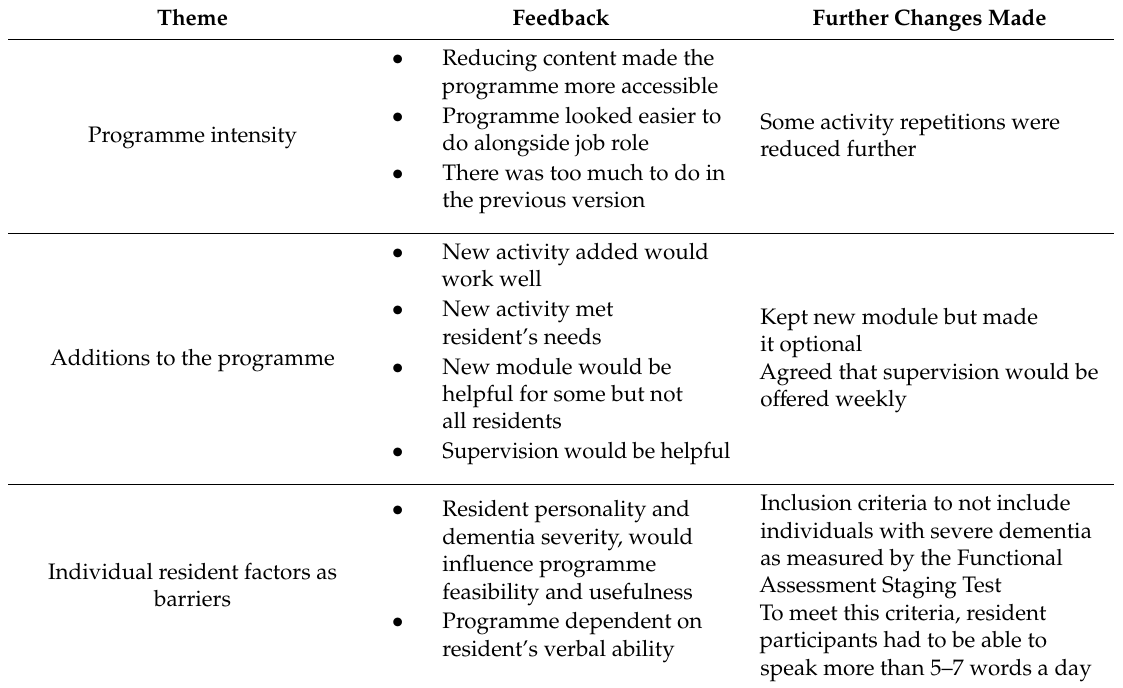
Table 1. Summary of consultation qualitative